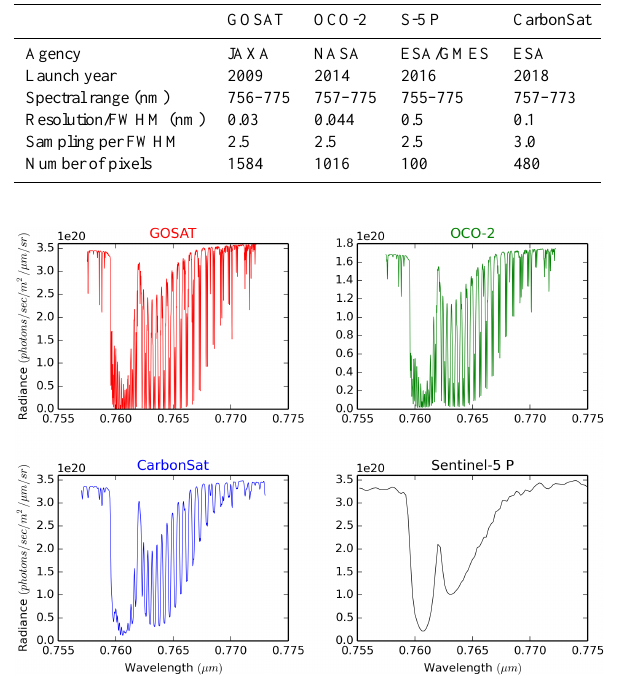
Figure 1. Simulated spectra for GOSAT, OCO-2, CarbonSat and S- 5 P for a solar zenith angle of 30 ◦ and a surface albedo of 0.5. An aerosol layer with optical depth of 0.3 at a height of 1km with a width of 1km is assumed.